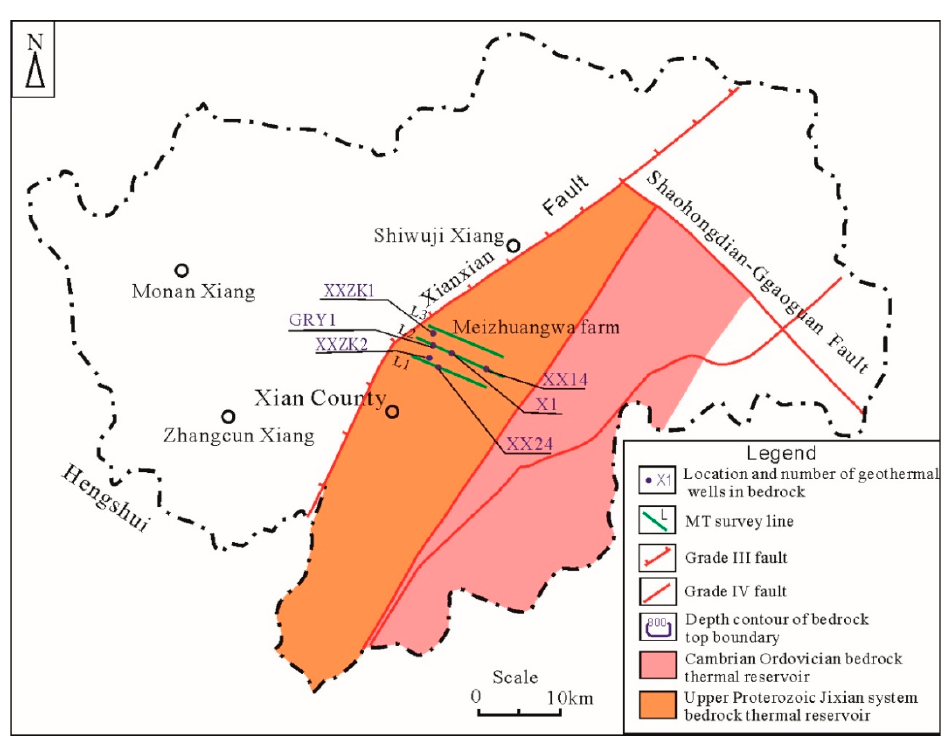
Figure 2. Distribution of the geothermal reservoirs of the bedrock and the locations of wells used for tracer tests in Xianxian County.